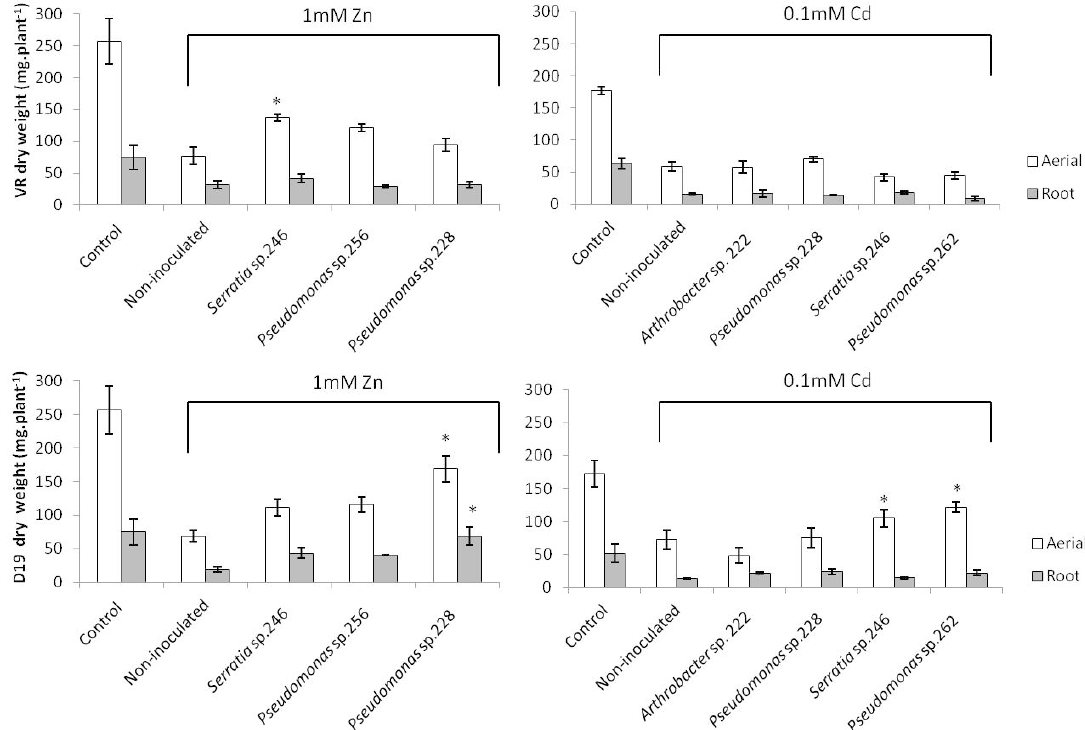
Figure 1. Dry weight (mg·plant − 1 ) of the H. tuberosus cultivars VR and D19 after three weeks of growth in presence of 1 mM Zn or 0.1 mM Cd. * Significant differences between inoculated and non-inoculated after Tukey’s test, p < 0.05; mean values ± SE; n = 4.